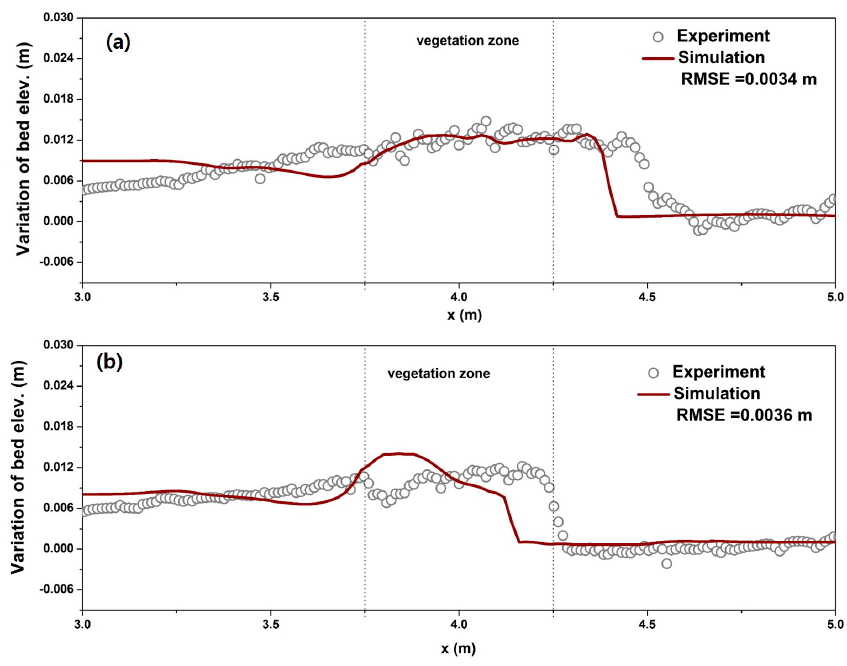
Figure 9. Longitudinal profiles of variation of bed elevation at y = 0.22 m for case 2: ( a ) low density and ( b ) high density.